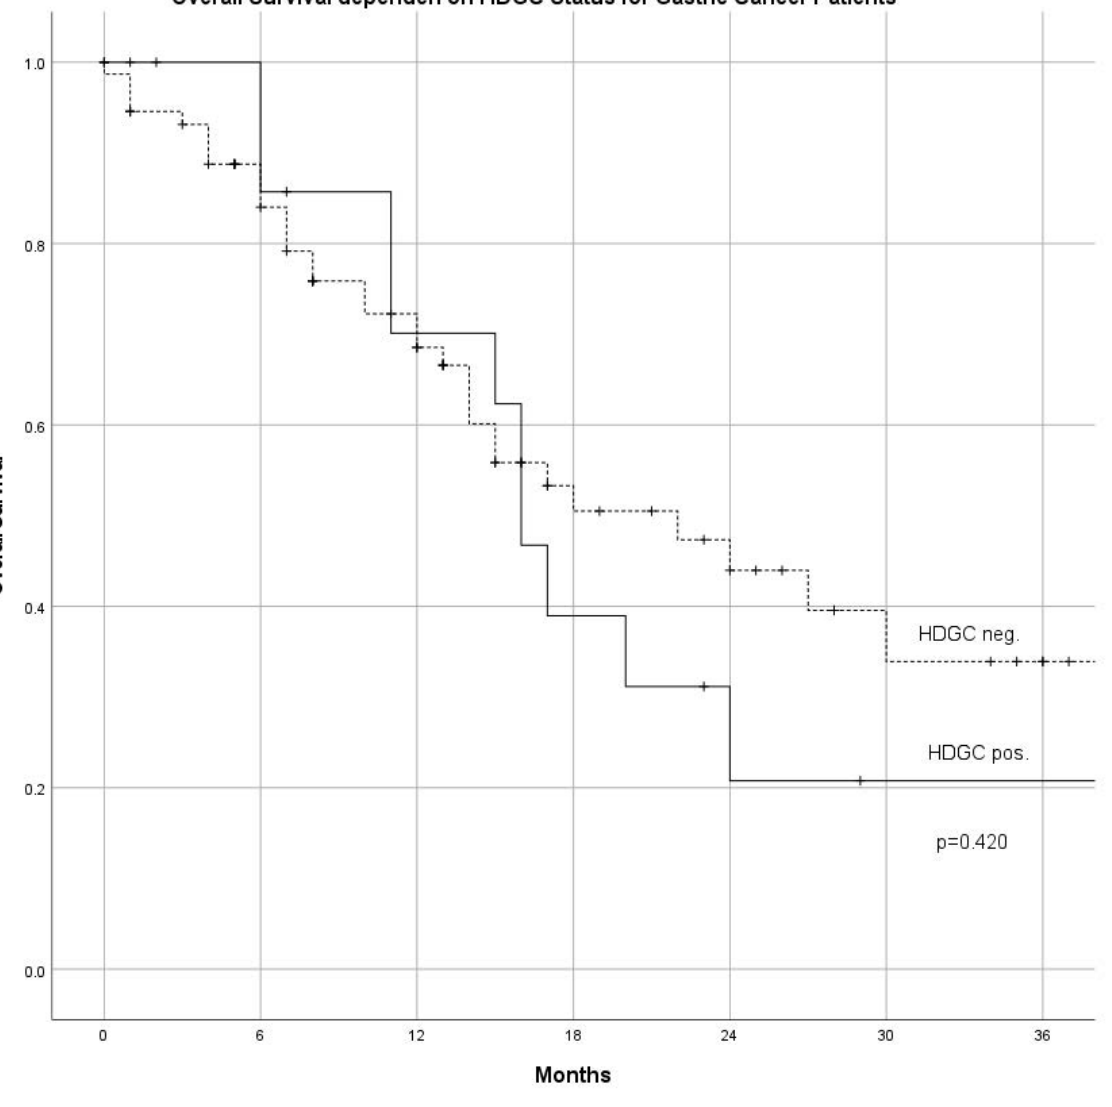
Figure 1. Overall survival in patients fulfilling criteria for HDGC (HDGC positive) compared with patients not fulfilling HDGC criteria (HDGC negative) (HDGC: hereditary diffuse gastric